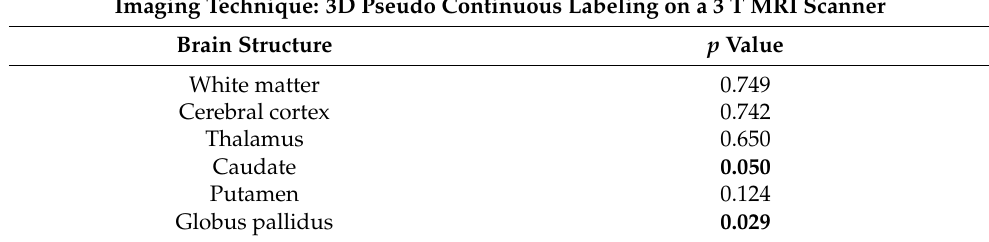
Table 7. p values for median CBF in ependymoma survivors versus healthy children of the same age